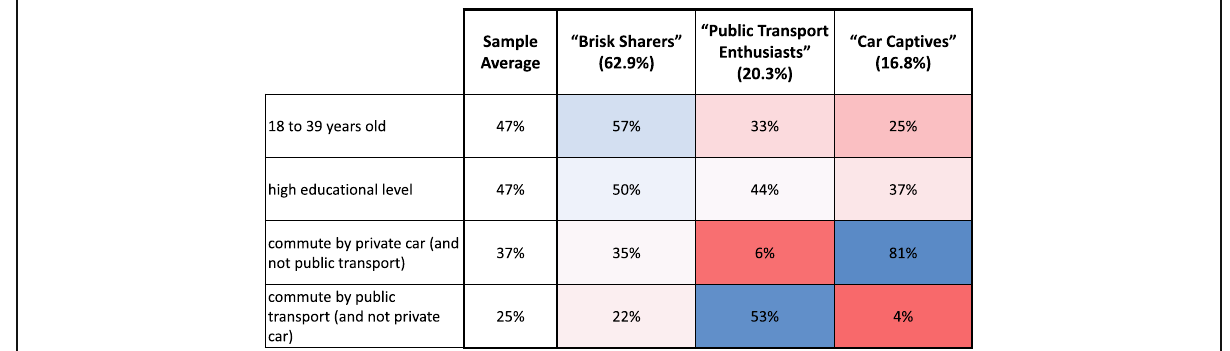
Fig. 3 Class membership probability per included socio-economic